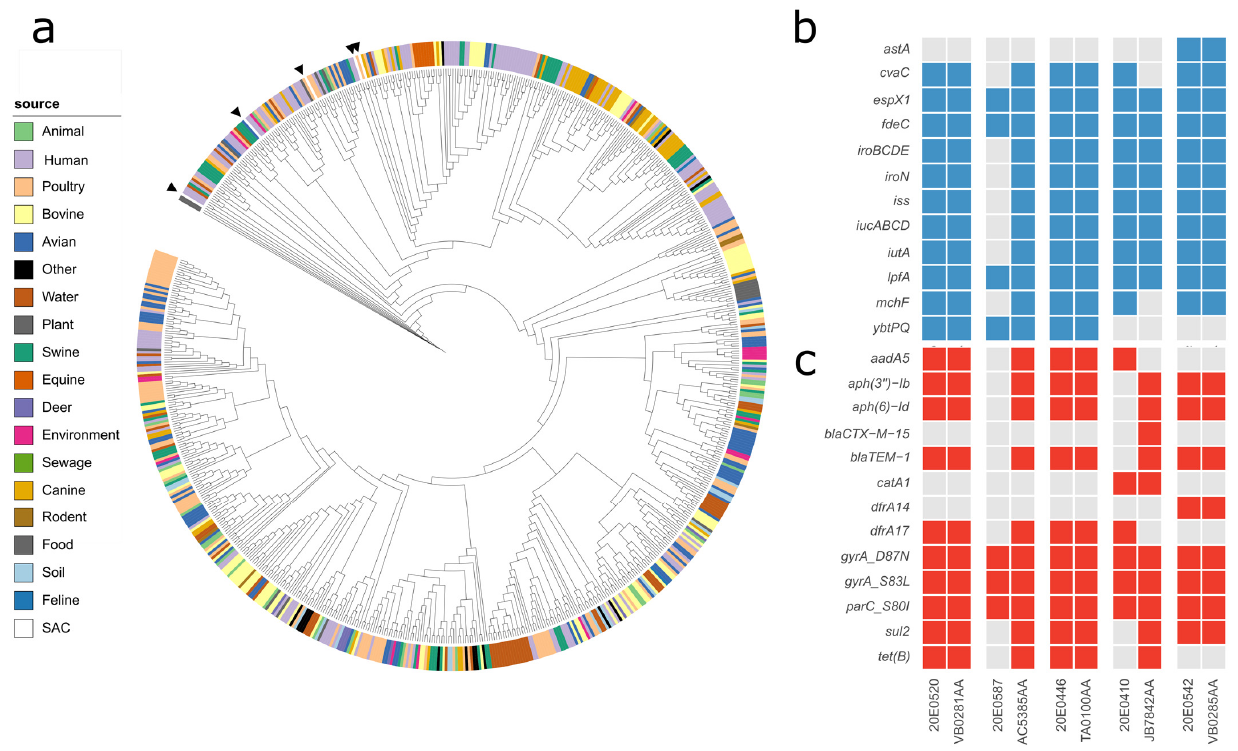
Figure 6. ( a ) Whole-genome sequencing tree of 721 E. coli ST162 sequences from Enterobase and five strains from the SAC collection, which are highlighted by black arrowheads. ( b , c ) Heat maps of the presence/absence of virulence factors ( b ) and AMR genes ( c ) ordered in pairs of the respective SAC strain and the nearest ST162 strain from Enterobase. The image was generated with ITOL (v.6)